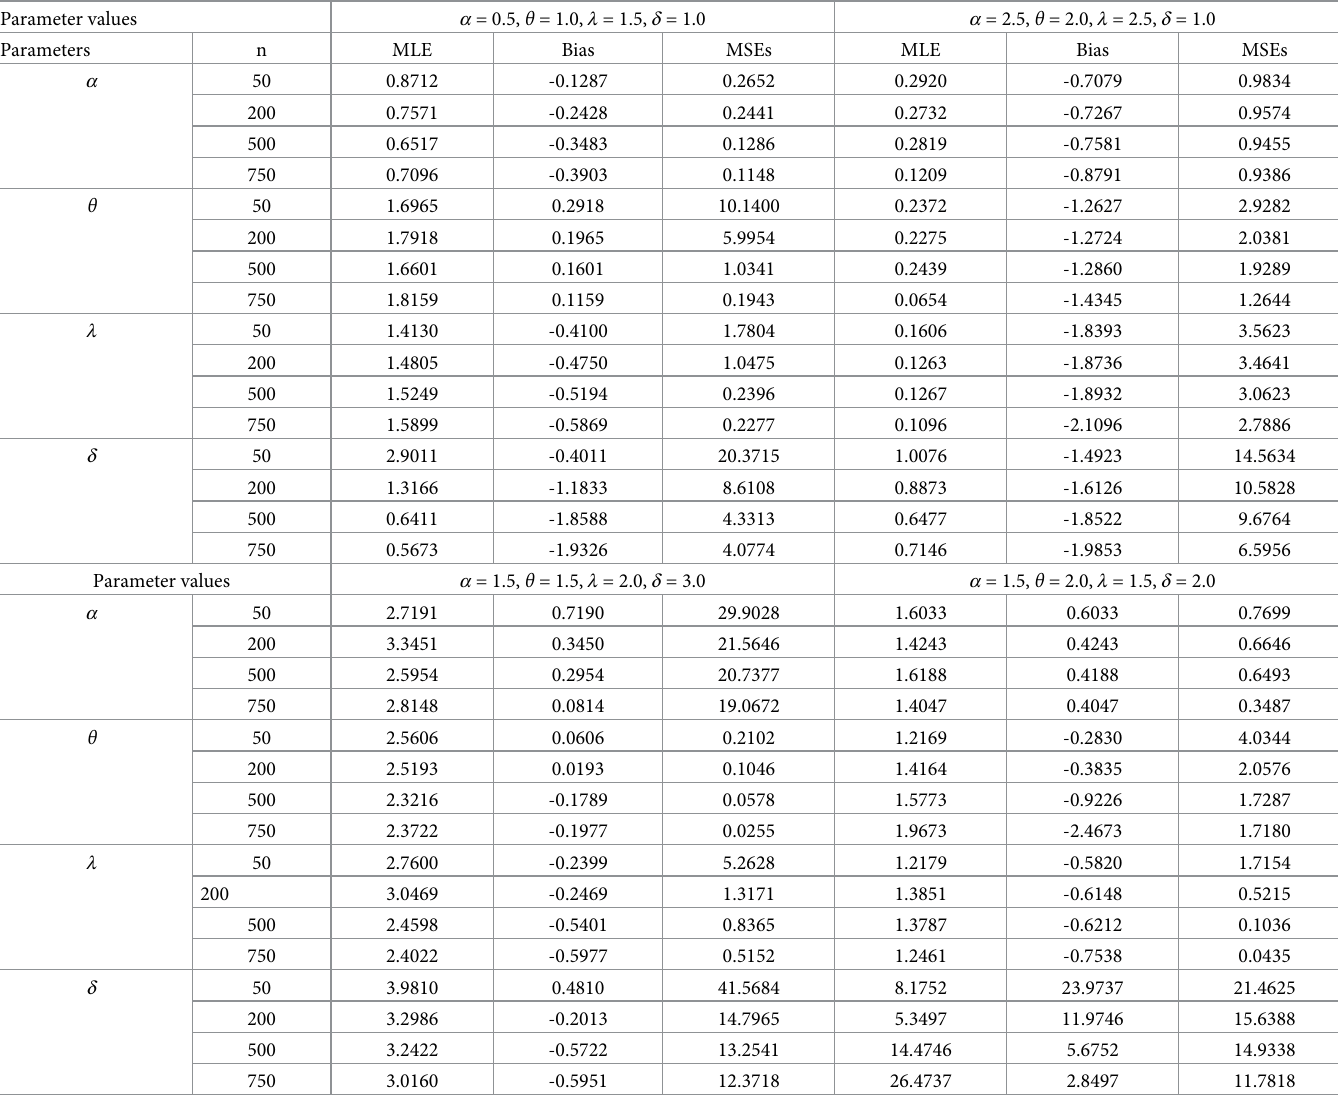
Table 1. MLE, average bias and MSEs of EOLE distribution. Parameter values